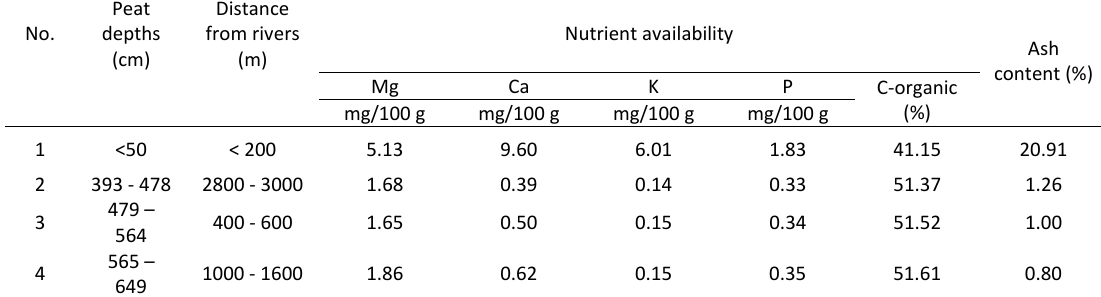
Table 3: Nutrient availabilities at various peat depths.